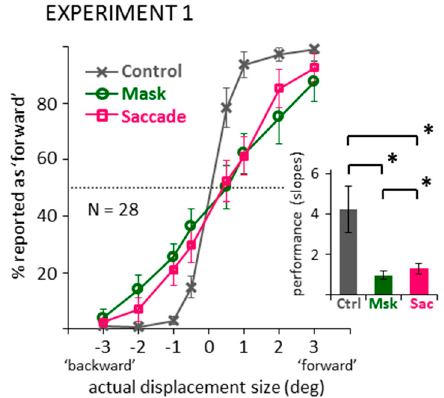
Figure 2. Data from the control, mask and saccade conditions of Experiment 1, recoded into binary displacement direction responses. Line graph shows actual displacements (negative: ‘backward’ vs. positive: ‘forward’) against the percentage of reported ‘forward’ responses (dotted line: chance level). Bar graph shows the average slopes of the logistic functions fitted to each participant’s individual data. All error bars: between-subjects 95% confidence intervals. Brackets marked with * illustrate significant differences in post-hoc paired-samples t -tests ( p < 0.05).